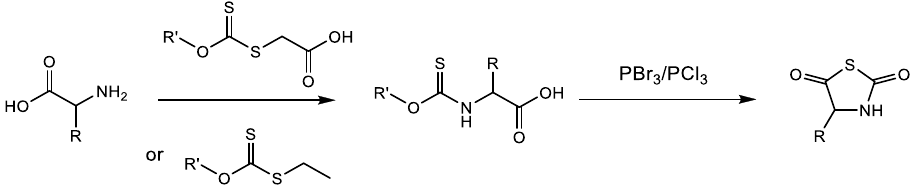
Figure 4. A common route to synthesize NTAs.